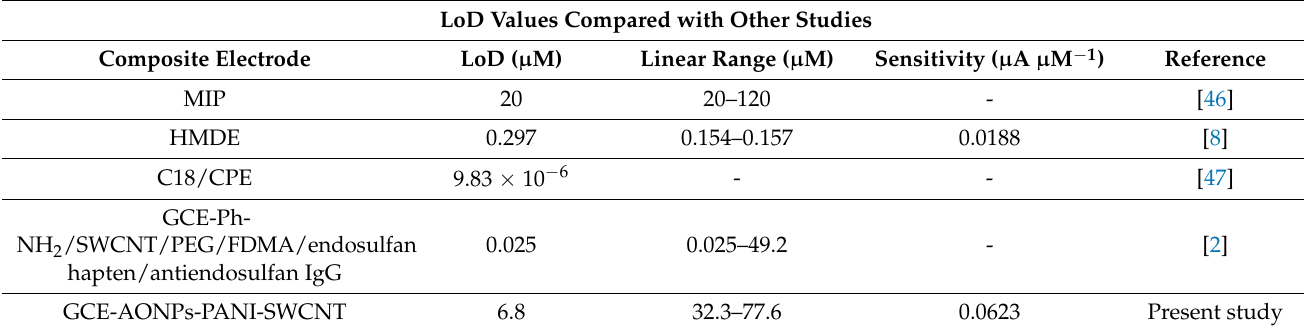
Table 1. Analytical performance of the proposed sensor for electrochemical detection of EDS. LoD Values Compared with Other Studies